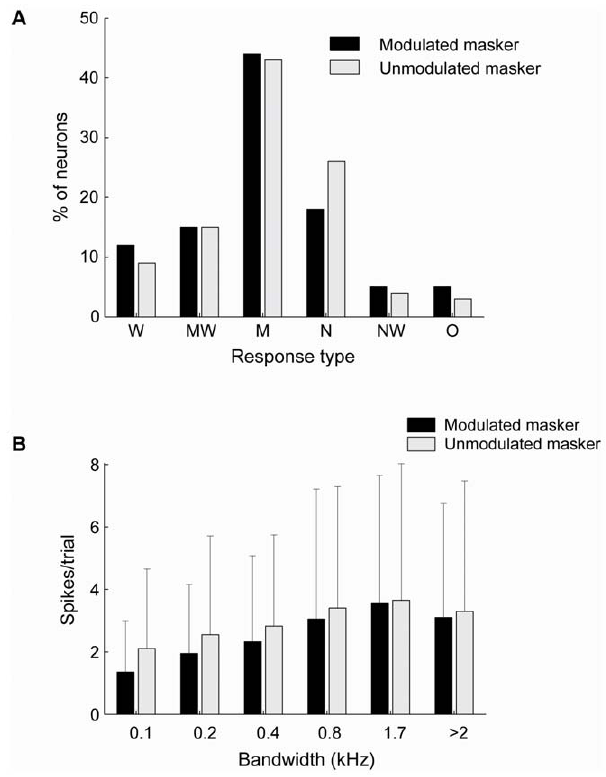
Figure 5. Population characteristics of the responses to M m and M u . A: Relative occurrence of the different types of response functions (see Fig. 4) for M m (black) and M u (gray). B: Median response over the population of neurons to M u (gray) and M m (black) having different bandwidths. Included are data from 109 neurons for which responses to both M m and M u were acquired. Errorbars indicate interquartile ranges; the large interquartile ranges illustrate the high variability of the neural responses.